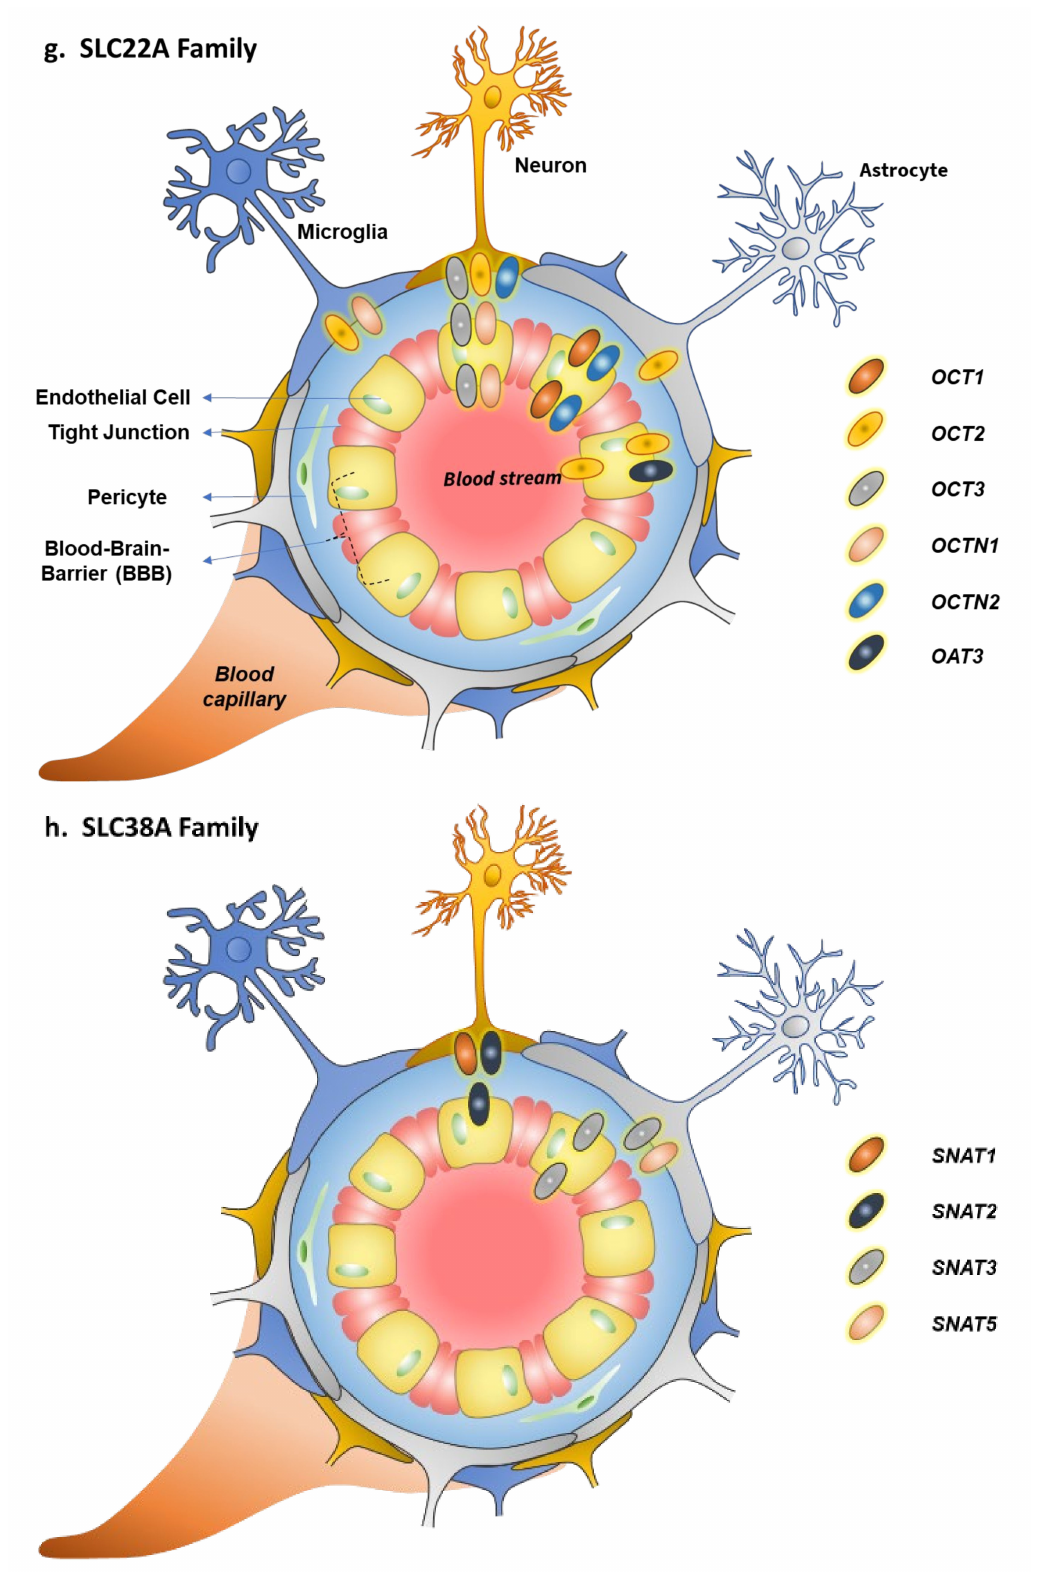
Figure 1. Neuro-glia vascular units illustrating transporter expression/localization of ( a ) of SLC1A-, ( b ) SLC2A-, ( c , d ) SLC7A-, ( e ) SLC16A-, ( f ) SLC21A-, ( g ) SLC22A-, and ( h ) SLC38A-families in different cell types. The transporters are illustrated with round-shaped objects with different